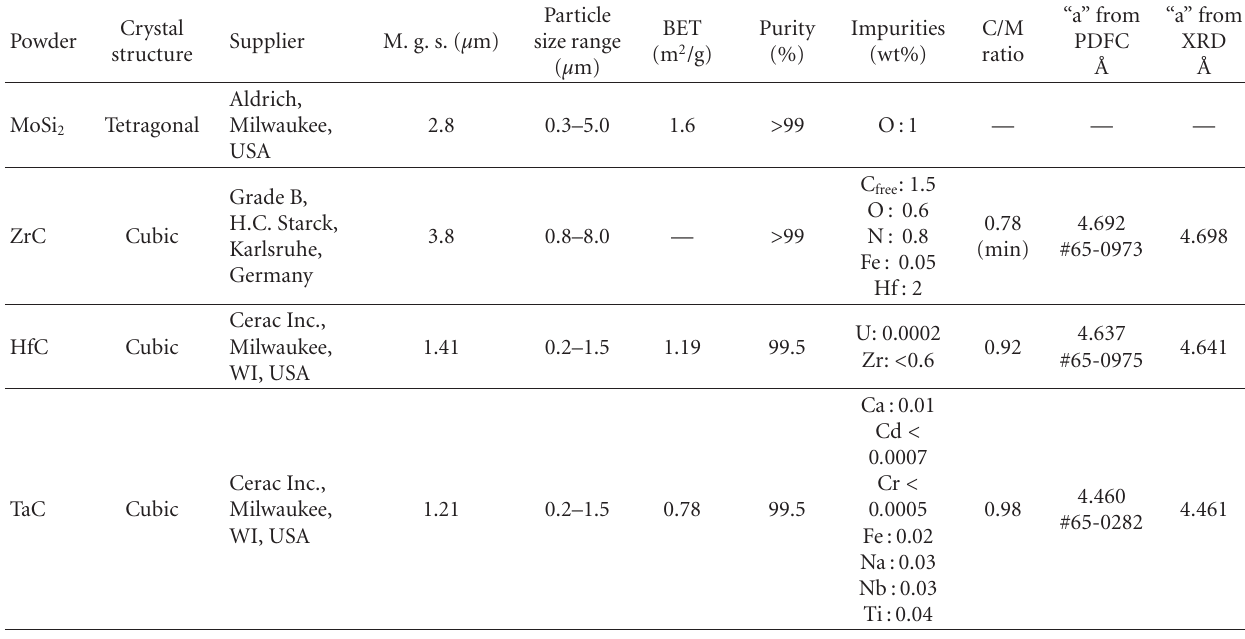
Table 1: Characteristics of the starting powders and lattice parameter “a” calculated by x-ray di ff raction. Crystal Powder